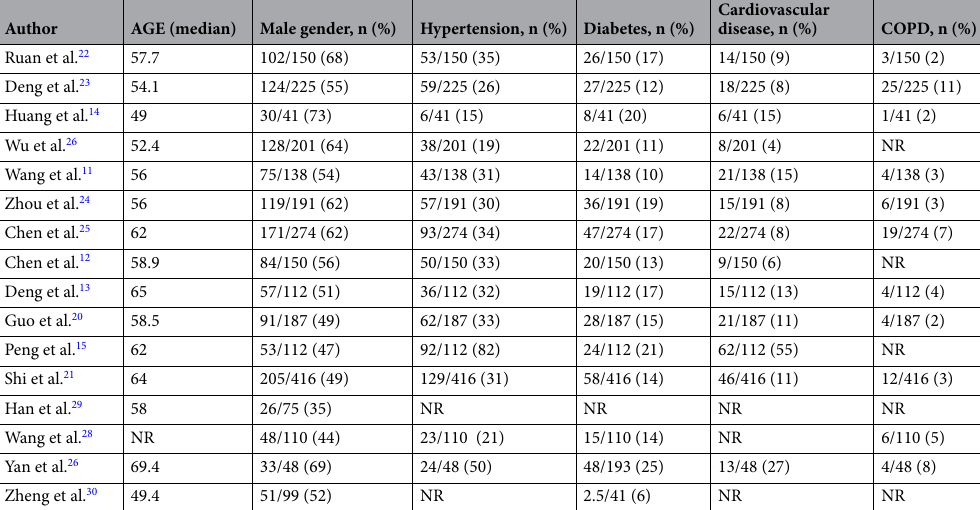
Table 2. Baseline Demographics of patients with COVID-19. NR not